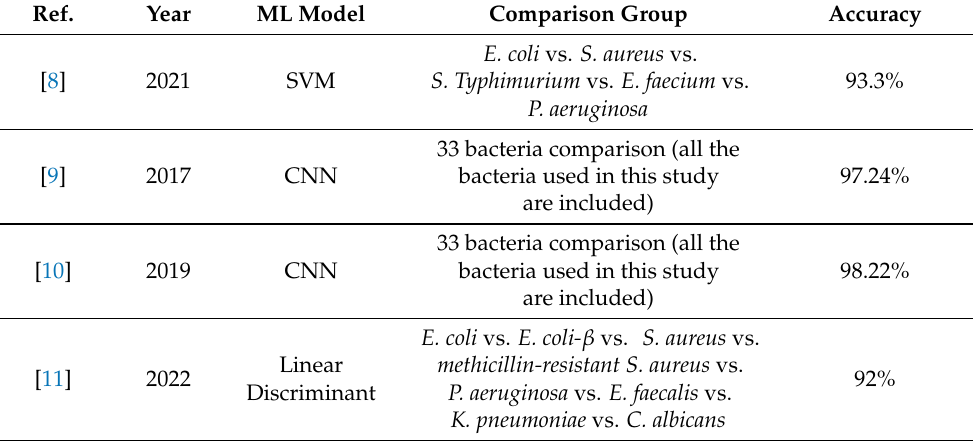
Table 1. State-of-the-art papers.